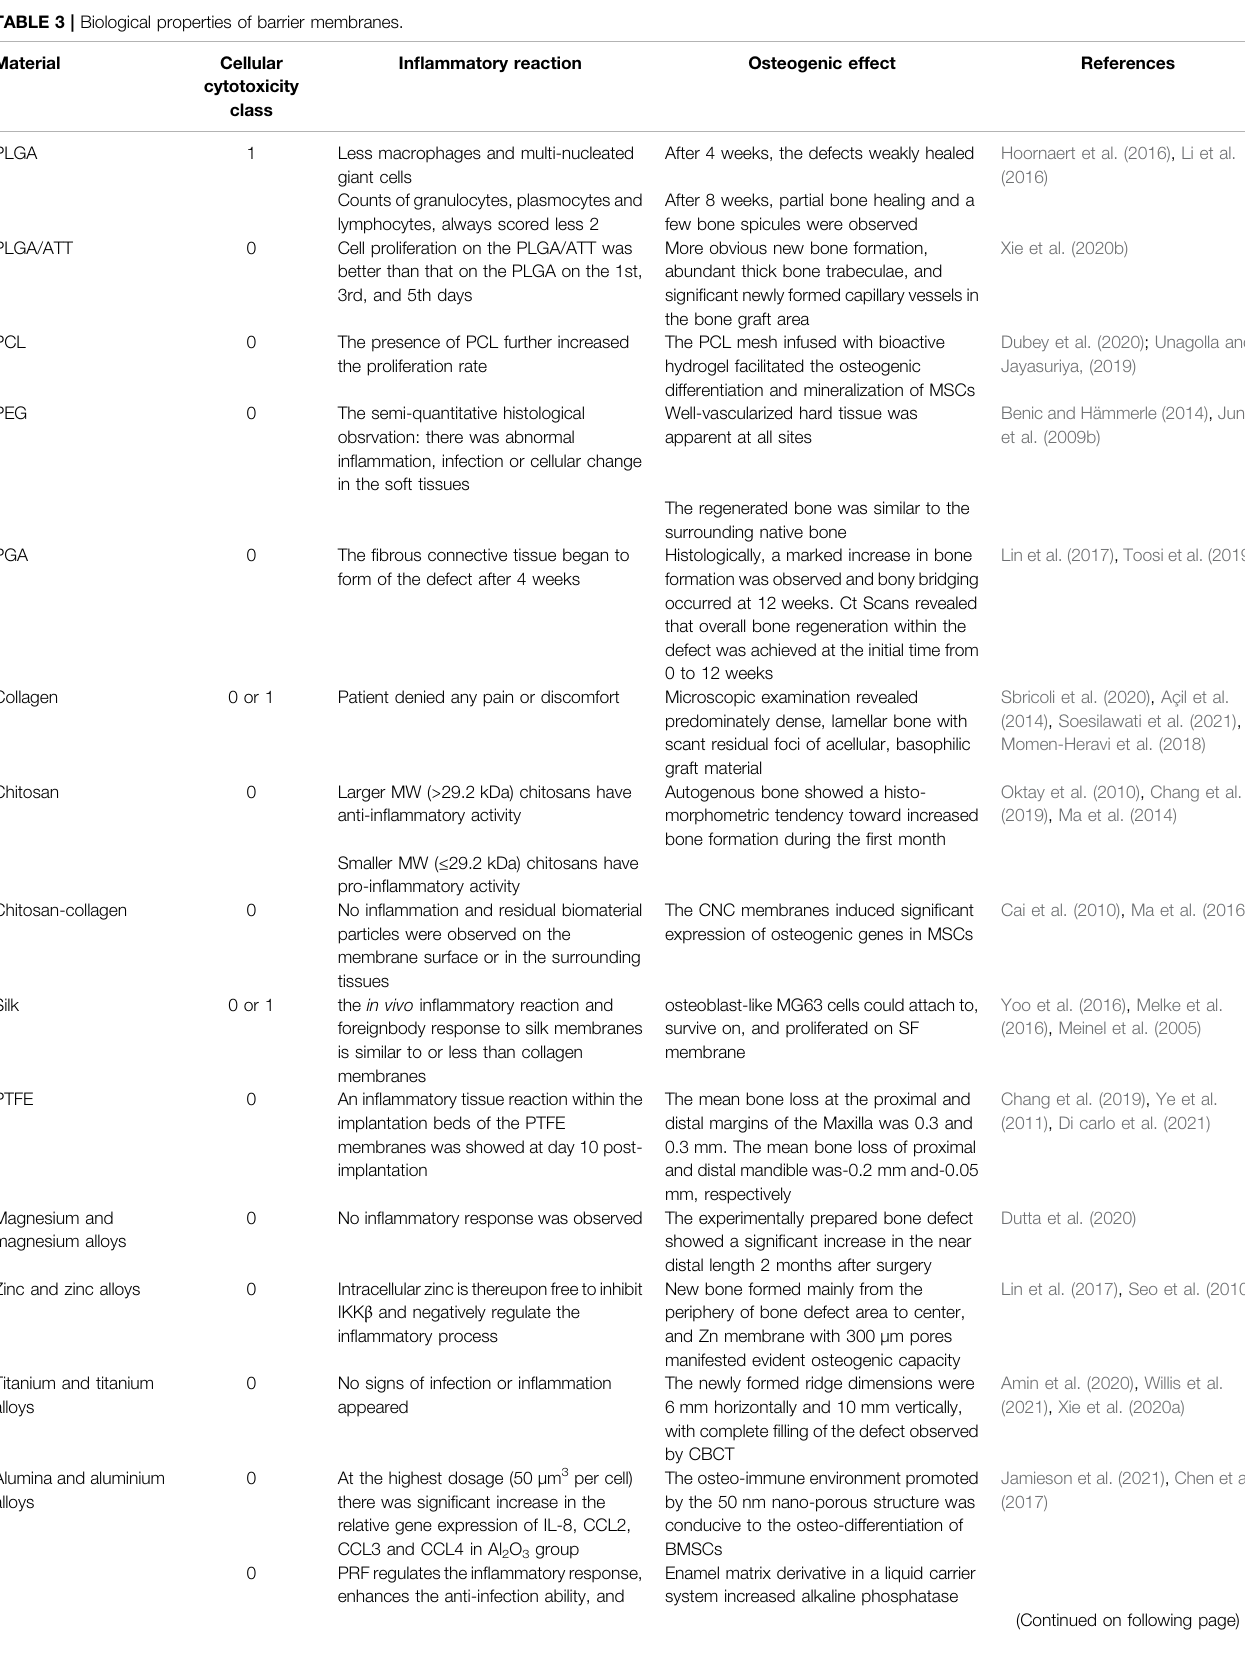
TABLE 3 | Biological properties of barrier